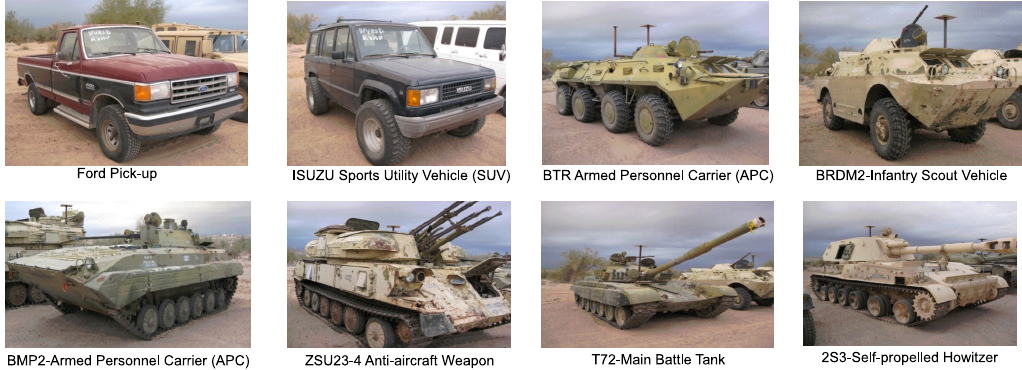
Figure 7. All eight targets we used for algorithm evaluation were from the SENSIAC